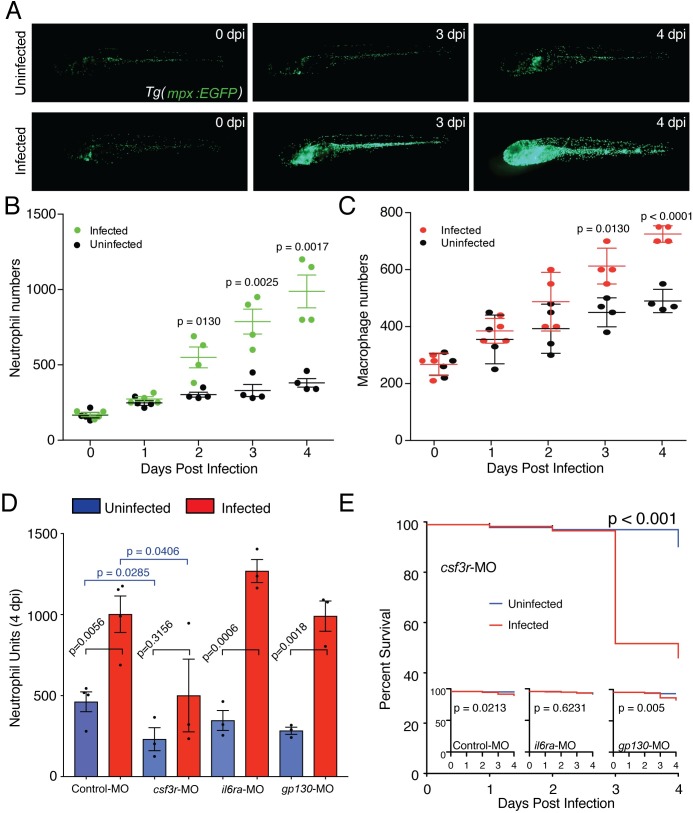
Zebrafish mount a Csf3r-dependent granulopoietic response to T. marneffei infection.(A) Low magnification images of infected and uninfected whole Tg(mpx:EGFP) embryos at 0, 3 and 4 dpi, displaying the profound infection-driven increase in EGFP-expressing neutrophil numbers. (B, C) Neutrophil (B) and macrophage (C) population expansion in infected versus uninfected embryos from 0–4 dpi. These data derive from enumerating neutrophil and macrophage numbers in the same embryos, of genotype Tg(mpx:EGFP/mpeg1:Gal4FF/UAS-E1b:Eco.nfsB-mCherry). Data displayed are mean±SD, n = 4 embryos/group. These data replicate other data derived from separately scoring these leukocyte populations in different embryos, in n≥2 independent other experiments. (D) Neutrophil population sizes at 4 dpi represented by Neutrophil Units in embryos injected with antisense morpholino oligonucleotides targeted to knockdown csf3-receptor (csf3r-MO) or interleukin-6 receptor (il6ra-MO and gp130-MO) Data are mean±SEM, n = 10 embryos/group/experiment, n≥3 experiments. Intragroup +/- infection p-values from 2-tailed unpaired t-test; p-values from intergroup comparisons involving csf3r-MO from 1-tailed unpaired t-test, given the a priori expectation of a reduction in neutrophil values in csf3r-deficiency [65, 95] (E) Kaplan-Meier life table analysis for the treatment groups shown in (C). Numbers/group (uninfected/infected): Control MO, 474/326; csf3r-MO, 443/233; il6ra-MO, 462/330; gp130-MO, 465/313. P-values from Gerhan-Breslow-Wilcoxon Test.